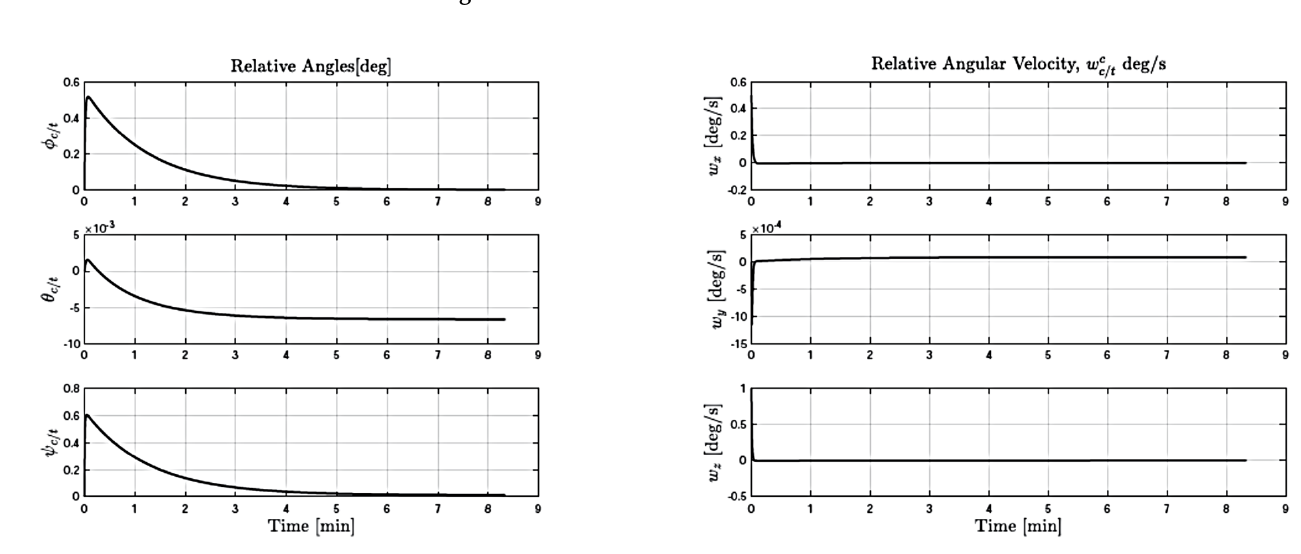
Figure A2. Attitude and attitude rate with